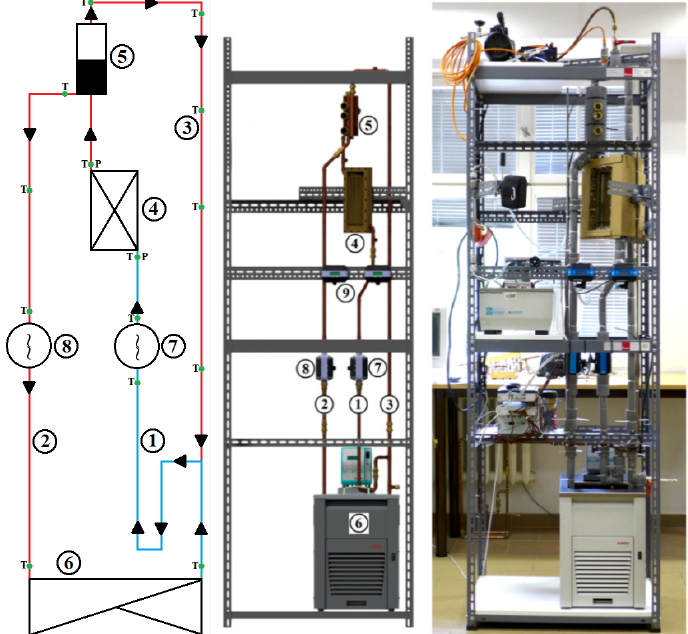
Figure 1. Scheme, model and photo of experimental facility: 1—cold (inlet) liquid pipeline, 2—hot (outlet) liquid pipeline, 3—hot (outlet) vapor pipeline, 4—minigap evaporator, 5—liquid-vapor separator, 6—condenser, 7—inlet ultrasonic flowmeter for cold liquid pipeline, 8—outlet ultrasonic flowmeter for hot liquid pipeline, 9—display, T—thermocouple, P—pressure transmitter.